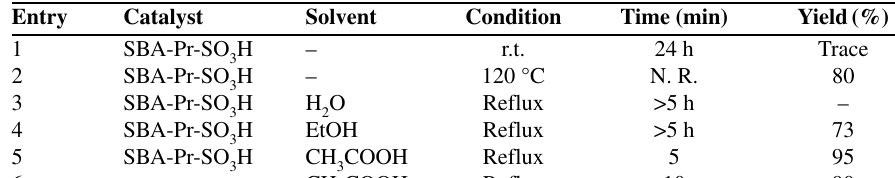
Table 1: Optimizing the reaction conditions for the synthesis of 4a.